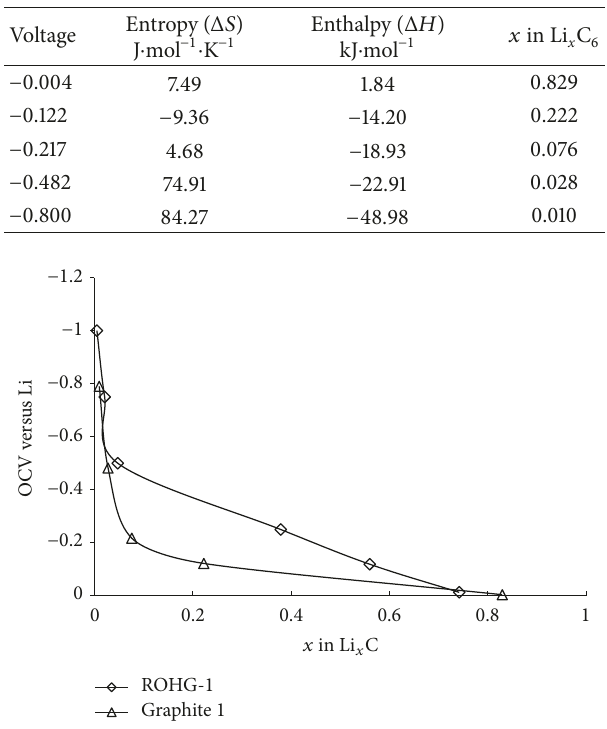
Figure 5: Relationship of Open Circuit Voltage (OCV) and mole fraction of lithium in carbon structure.